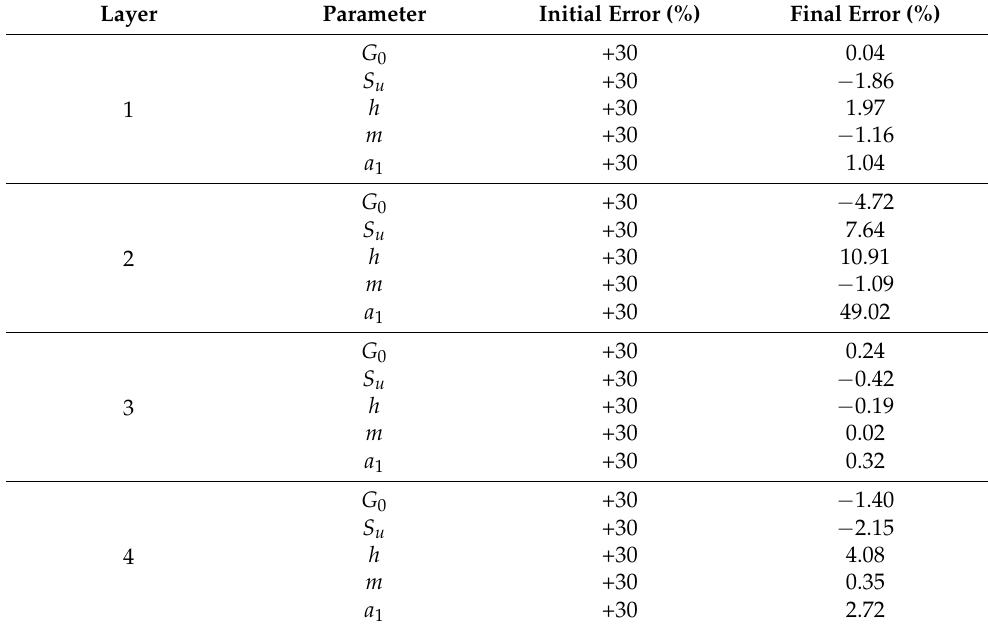
Table 1. The initial and final error of estimation parameters for Case Study 1.